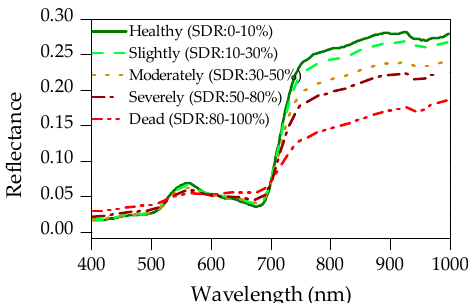
Figure 6. The mean reflectance value of different SDR at 400 – 1000 nm wavelengths.